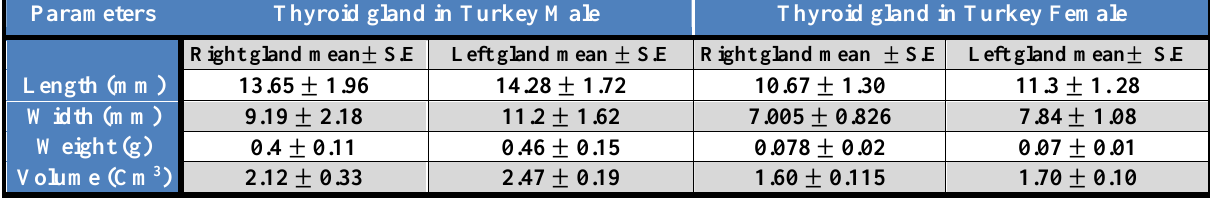
Table, 1: Dimensions of Thyroid gland in the Male and Female of local breed Turkey Meleagris gallopavo.